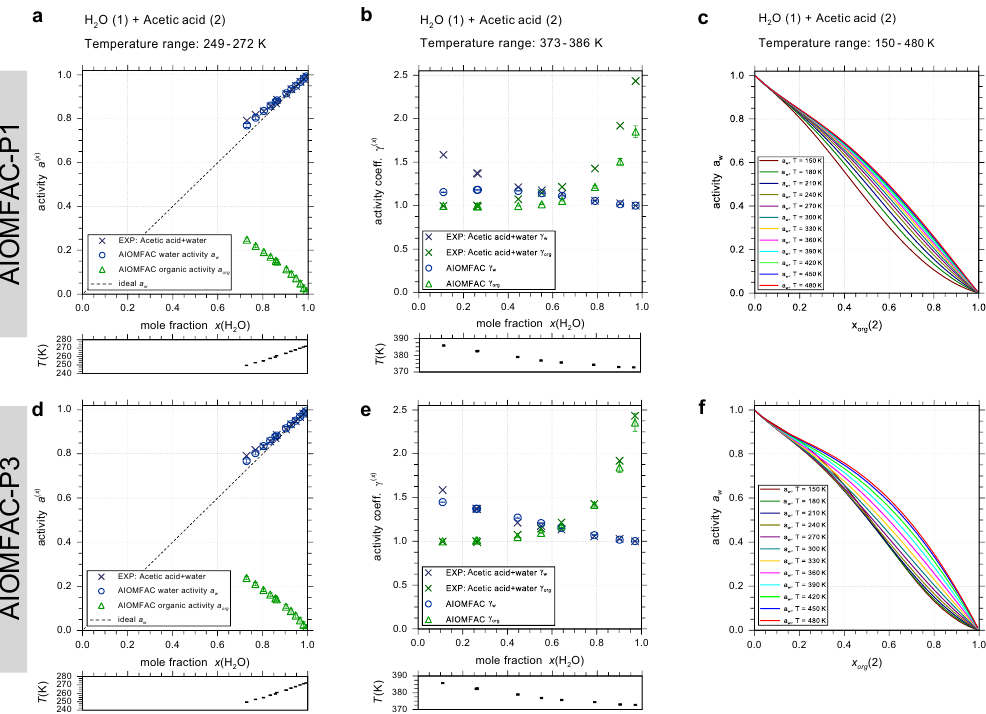
Figure 3. SLE and VLE measurements for water (1) + acetic acid (2) solutions and corresponding calculations of AIOMFAC-P1 (a–c) or AIOMFAC-P3 (d–f) . The coloured curves in (c, f) represent the temperature dependence of water activities predicted for the range 150–480K. (a, d) Low temperature experimental SLE data (crosses) are compared with the predictions for water activity at the same compositions and temperatures (blue circles). Predictions of the corresponding organic activities are shown as well (green triangles). The dashed line represents the hypothetical water activity of an ideal mixture. The error bars represent the model sensitivity to a composition variation by x tol = 0 . 01. Panels (b, e) show the model predictions of the activity coefficients compared to VLE data covering temperatures significantly higher than room temperature. The temperatures of the individual data points are given in the boxes below the main panels. Experimental data: Faucon (1910) and Narayana et al.